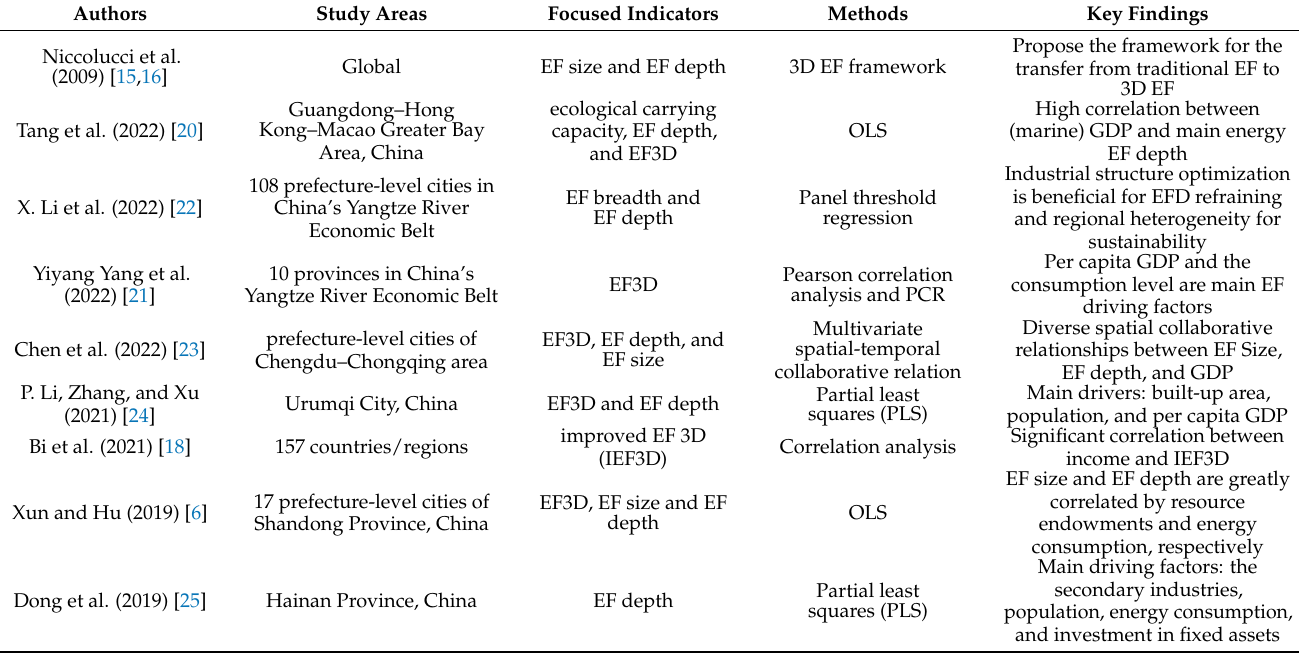
Table 1. Literature on 3D EF and its driving